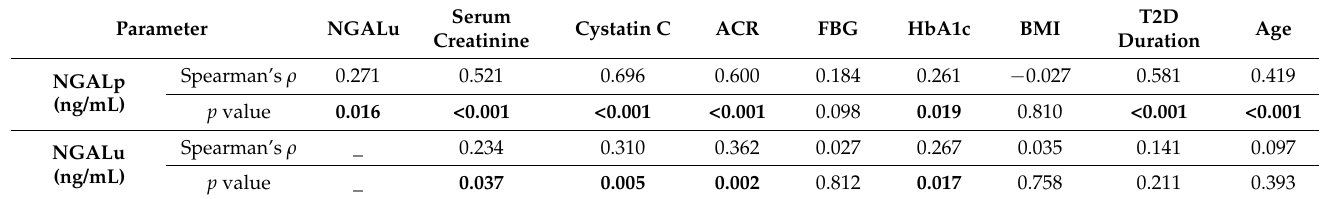
Table 2. Spearman’s correlation analysis of plasma and urine NGAL with DKD indices and gly- cometabolic parameters in patients with T2D (N = 84).